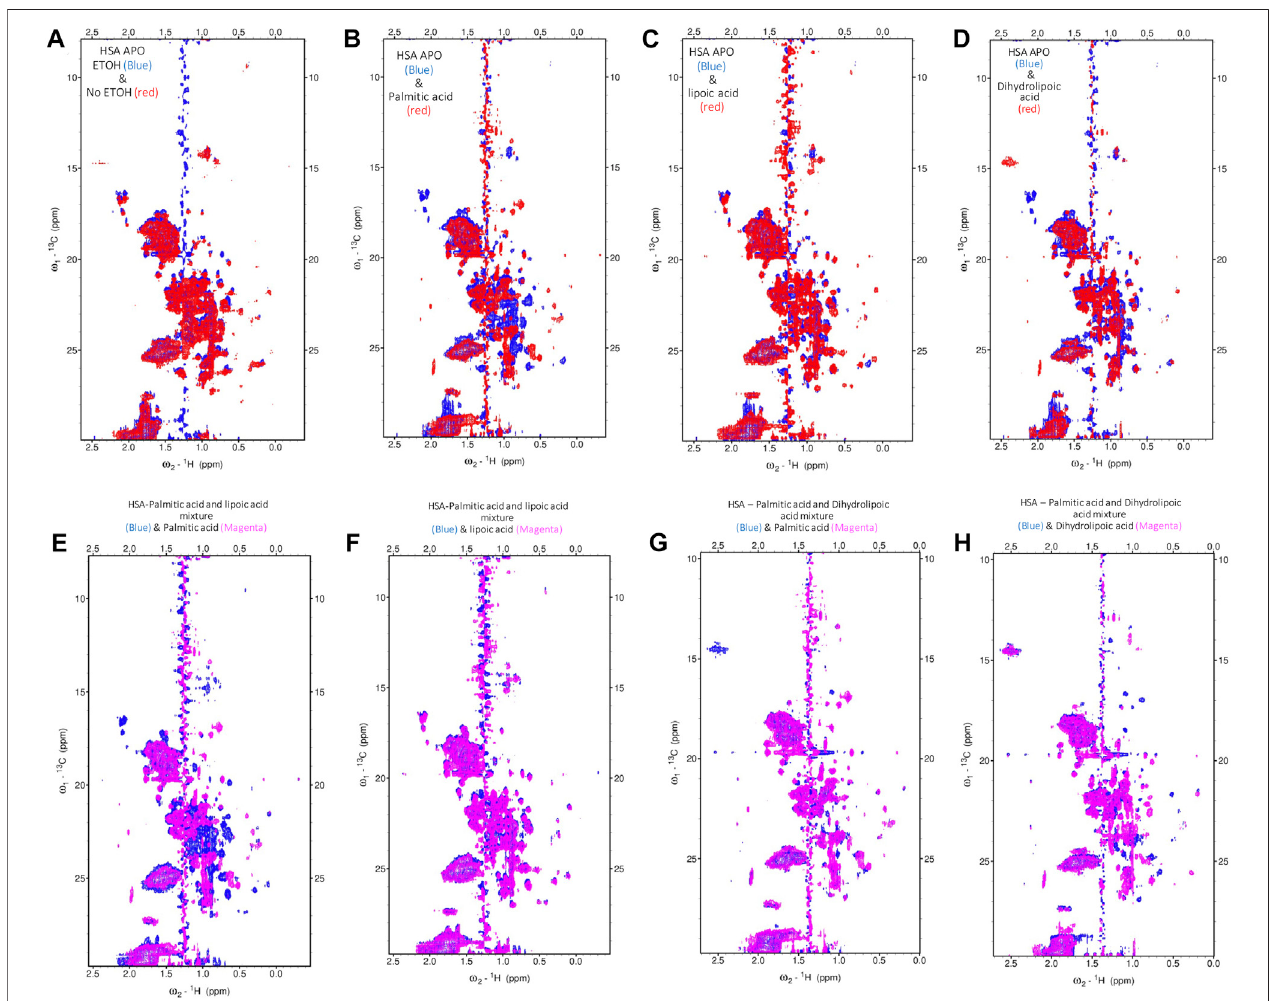
FIGURE4| ProbingtheconformationalchangesofHSAwithhigh-resolutionNMR.The2D[ 1 H- 13 C]SOFASTmethyl - TROSYspectra. (A) Free-HSAspectrumwith 1% (v/v) ETOH (blue) overlaid with free HSA without ETOH (red). (B) Free-HSA spectrum with ETOH (blue) overlaid with palmitic acid (red). (C) Free-HSA spectrum with ETOH (blue) overlaid with lipoic acid (red). (D) Free-HSA spectrum with ETOH (blue) overlaid with dihydrolipoic acid (red). (E) HSA-palmitic acid and lipoic acid mixture (blue) overlaid with palmitic acid (magenta). (F) HSA-palmitic acid and lipoic acid mixture (blue) overlaid with lipoic acid (magenta). (G) HSA-palmitic acid and dihydrolipoic acid mixture (blue) overlaid with palmitic acid (magenta). (H) HSA-palmitic acid and dihydrolipoic acid mixture (blue) overlaid with dihydrolipoic acid (magenta).